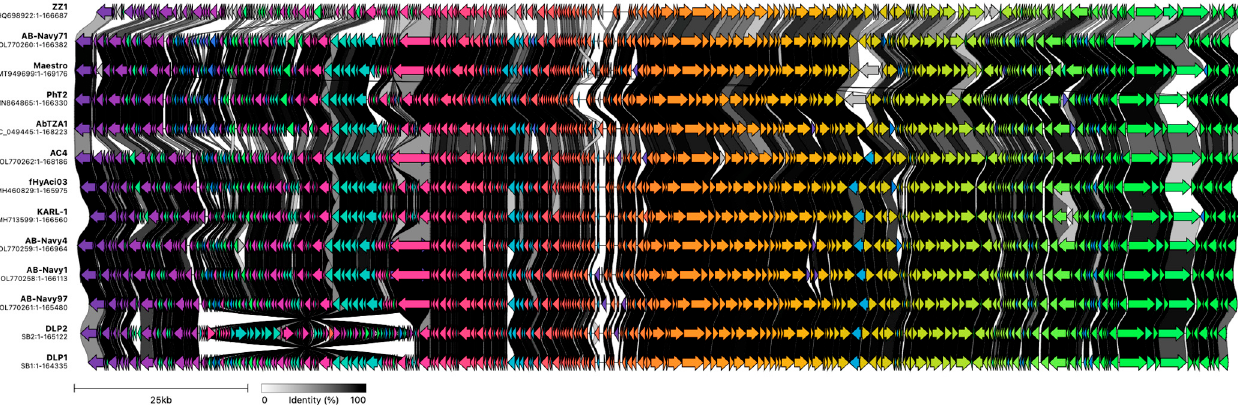
Figure 14. A Clinker gene cluster comparison of Acinetobacter T4-like phages. Comparison of whole genomes for Acinetobacter phages DLP1 and DLP2 against 11 other T4-like phages with percent amino acid identity represented by greyscale links between genomes. Each similarity group is assigned a unique color.